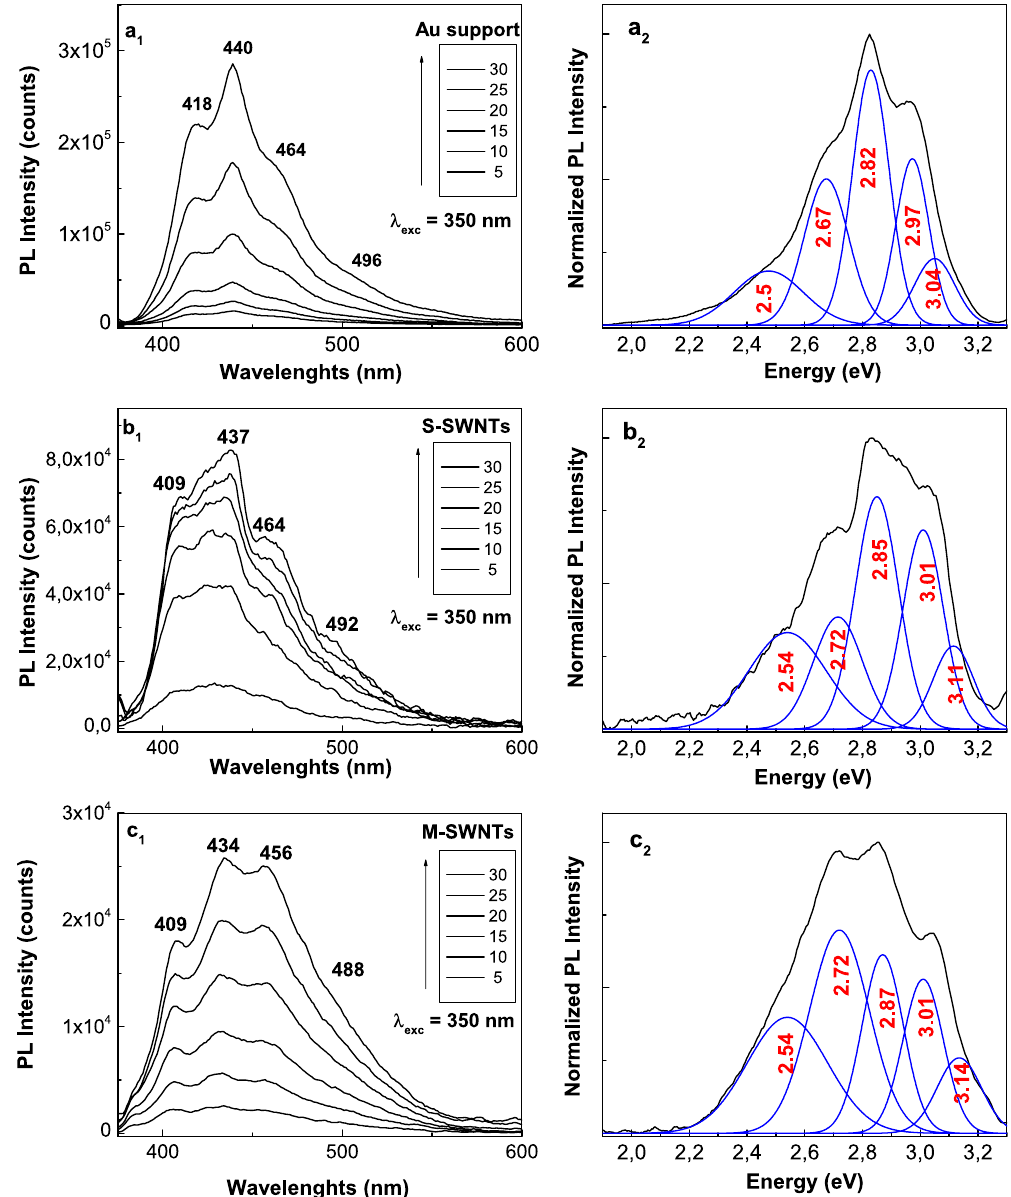
Figure 4. The PL spectra of PANI doped with Cl − ions electrosynthesized onto the blank Au electrode ( a 1 ) and the Au plates covered with a film of S-SWNTs ( b 1 ) and M-SWNTs ( c 1 ) during 5, 10, 15, 20, 25 and 30 CVs. De- convolution of the PL spectra recorded after 30 CVs onto the blank Au electrode ( a 2 ) and the Au plates covered with a film of S-SWNTs ( b 2 ) and M-SWNTs ( c 2